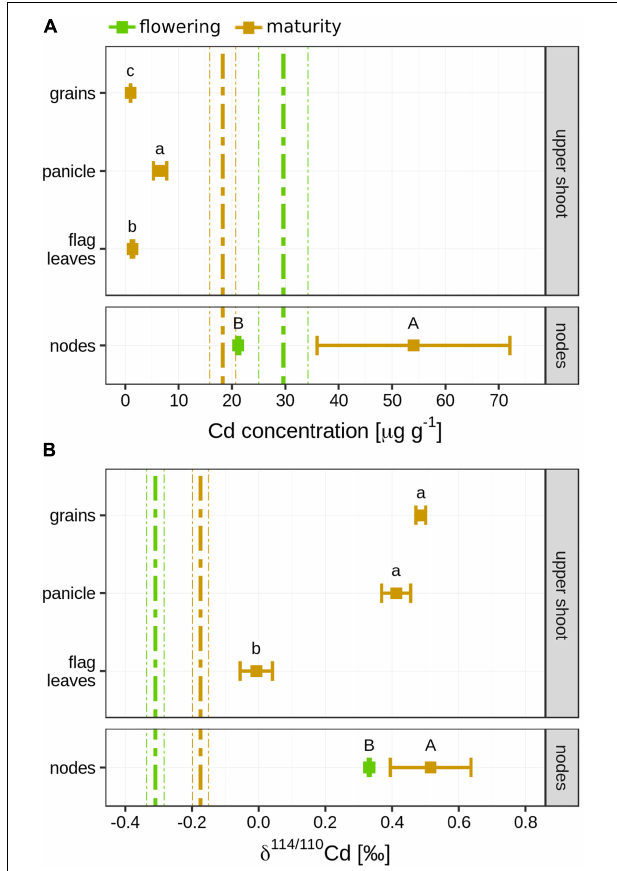
FIGURE 3 | (A) Mean Cd concentration in different shoot parts. Upper shoot: error bars denote the standard deviation of n = 4 experimental replicates sampled at maturity. Letters indicate statistical difference of the mean determined by using a Kruskal–Wallis test. Dashed vertical line indicate mean Cd concentration ( ± 1 sd) of the entire shoot. Nodes: error bars denote the standard deviation of n = 2 experimental replicates at flowering and maturity. (B) Mean Cd isotope ratios in different shoot parts. Upper shoot: error bars denote the standard deviation of n = 4 experimental replicates sampled at maturity. Letters indicate statistical difference of the mean determined by using a Kruskal–Wallis test. Vertical line indicates mean isotope ratio ( ± 1 sd) of the shoot. Nodes: error bars denote the two standard deviations ( ± 2 sd) of n = 2 experimental replicates at flowering and